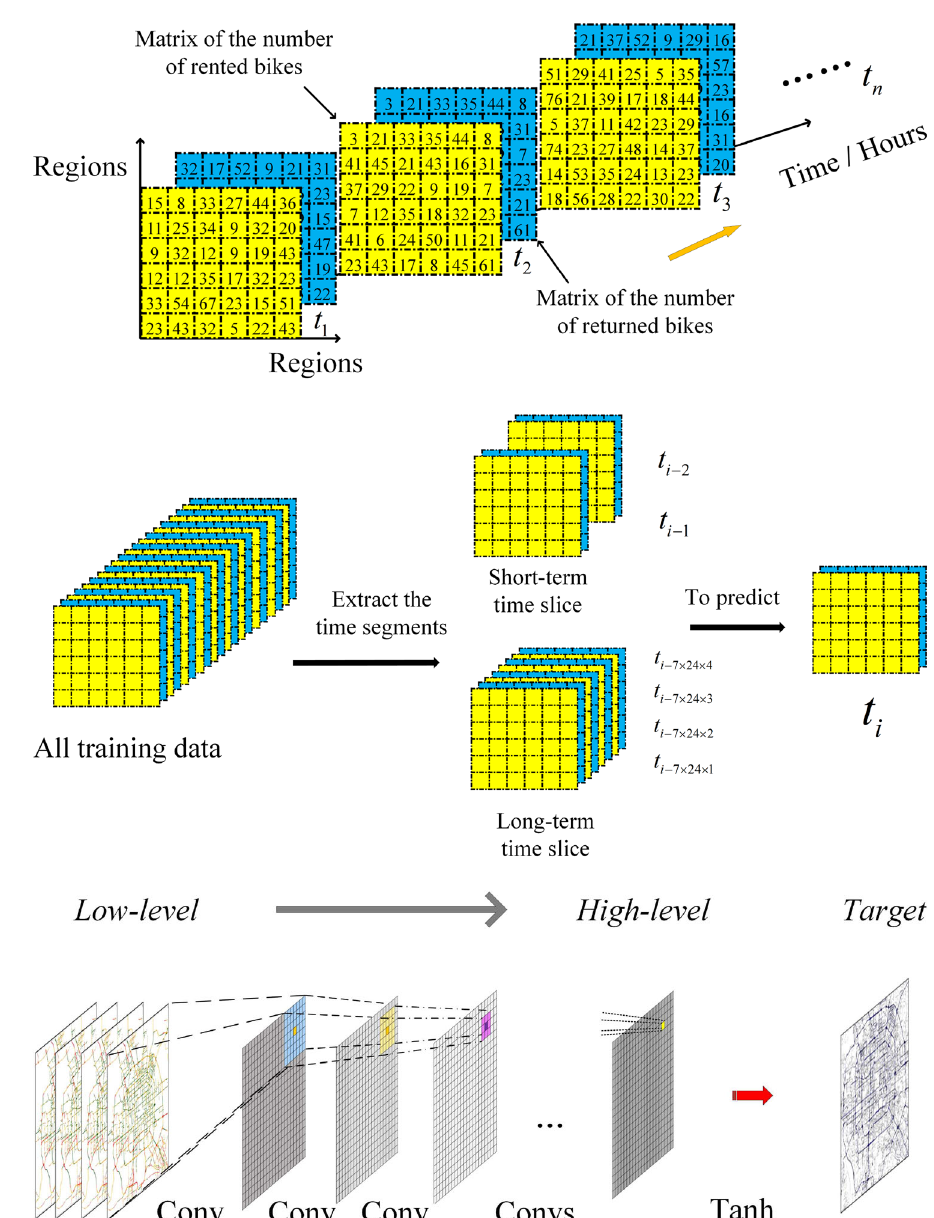
Fig. 6 Four-dimensional array of rented and returned bikes